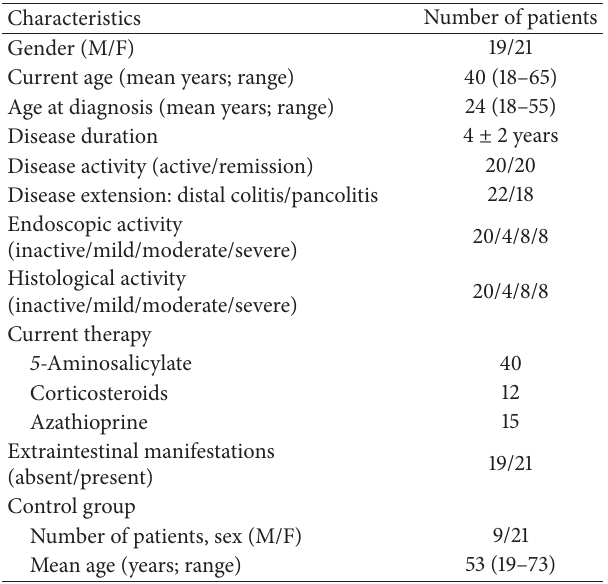
Table 2: Clinical and demographic characteristics of ulcerative colitis